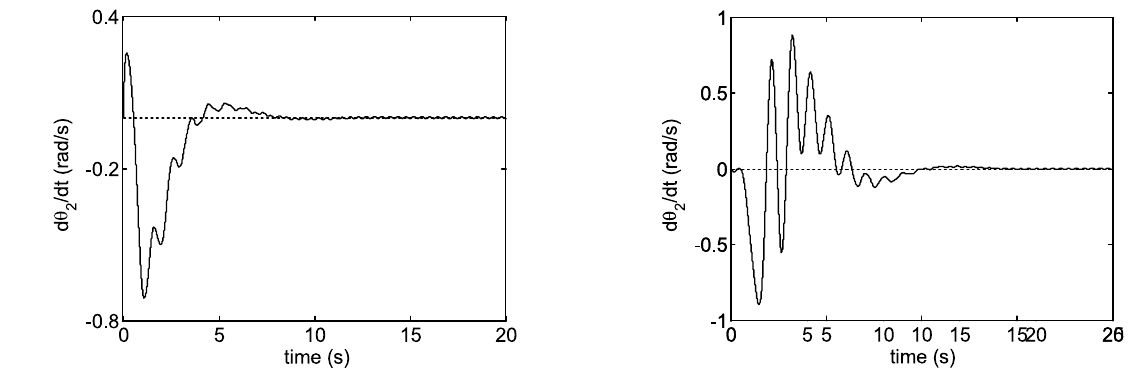
Fig. 11. Estimated behavior of variable ˙ θ 2 considering same initial conditions for the angular displacements.